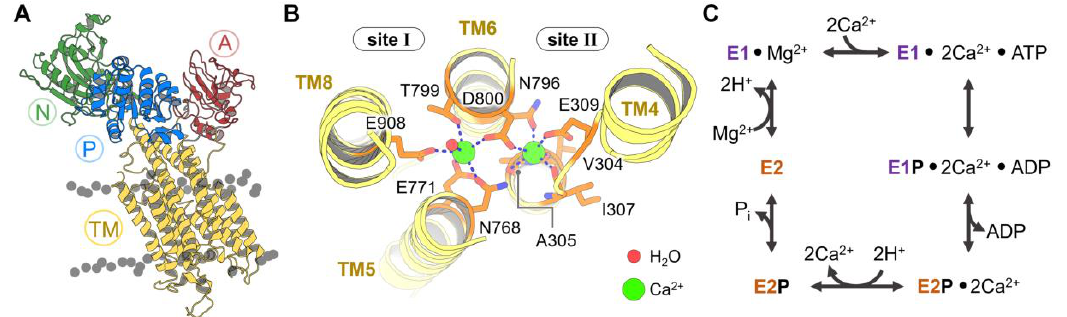
Figure 1. ( A ) Three-dimensional structure of the cytosolic N (green), A (red), and P (blue) domains and transmembrane helices (TM, yellow) of sarcoendoplasmic reticulum calcium ATPase (SERCA). ( B ) Close-up view of calcium binding sites I and II of SERCA showing two Ca 2+ ions (green) and the interactions stabilizing their position in these sites. ( C ) Schematic representation of the Post-Albers pumping cycle of SERCA.